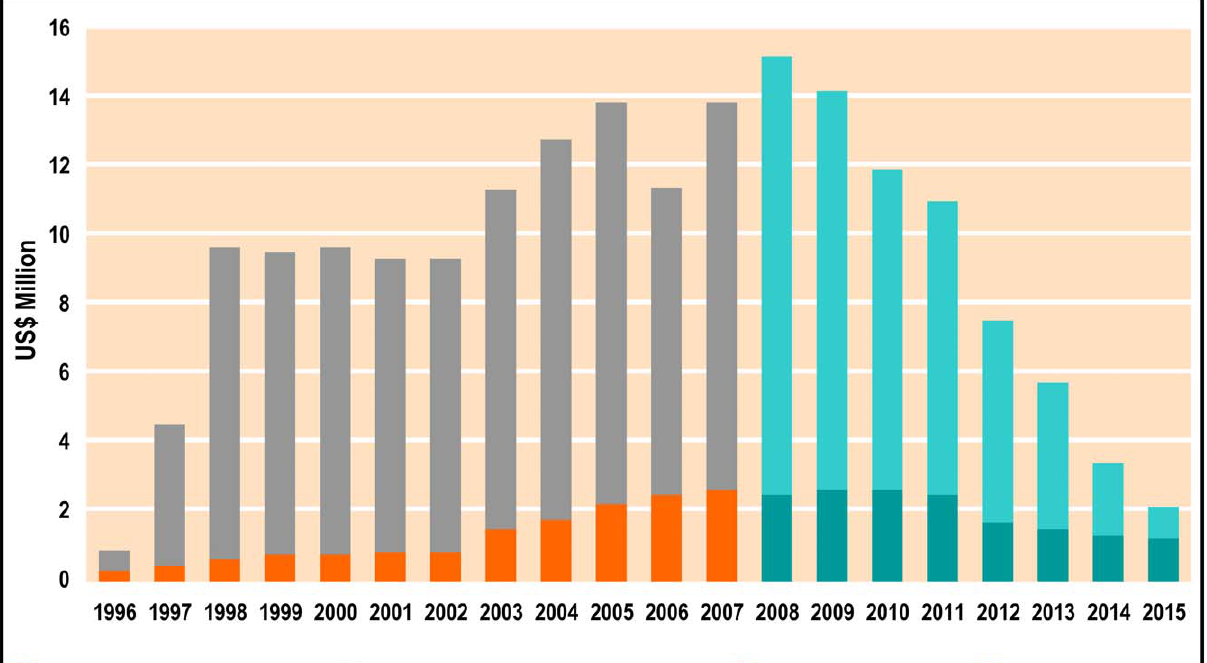
Figure 2. African Programme for Onchocerciasis Control Trust Fund annual expenditure. Since theinceptionof APOCin 1995,expenditure has increased steadily until 2007, mainly with external donor support (listed in http://www.who.int/apoc/about/funding/en/index.html). The orange and dark turquoise portion of the bars represents investment in administration, and the grey and light turquoise portions indicate support for technical activities, operations research, and capacity building. External funding has decreased since 2007 and it is anticipated that from 2015 onwards the programme will be fully devolved to participating countries and their NGDOs. Recently, APOC’s mandate has been extended to 2025.